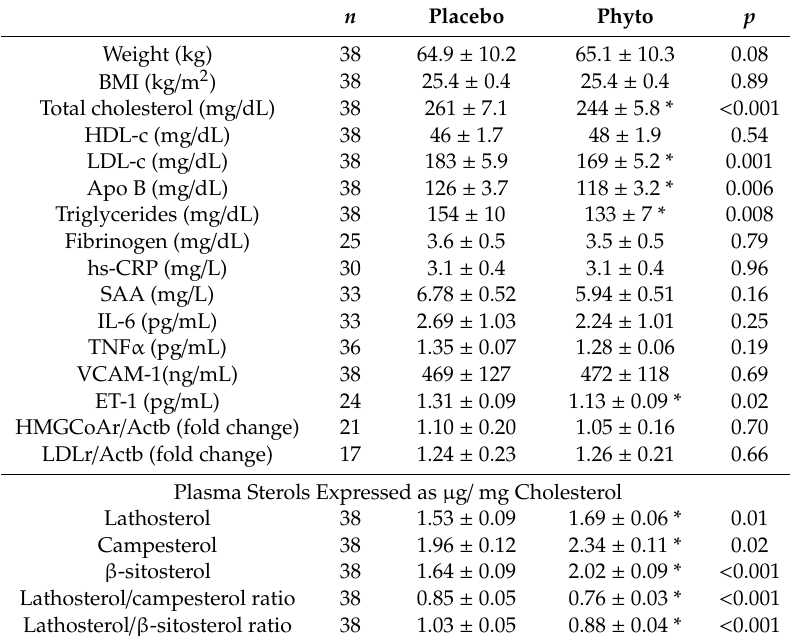
Table 3. Body weight, BMI, biochemical analysis, mRNA, and plasma sterol concentrations of moderately hypercholesterolemic subjects after supplementation.